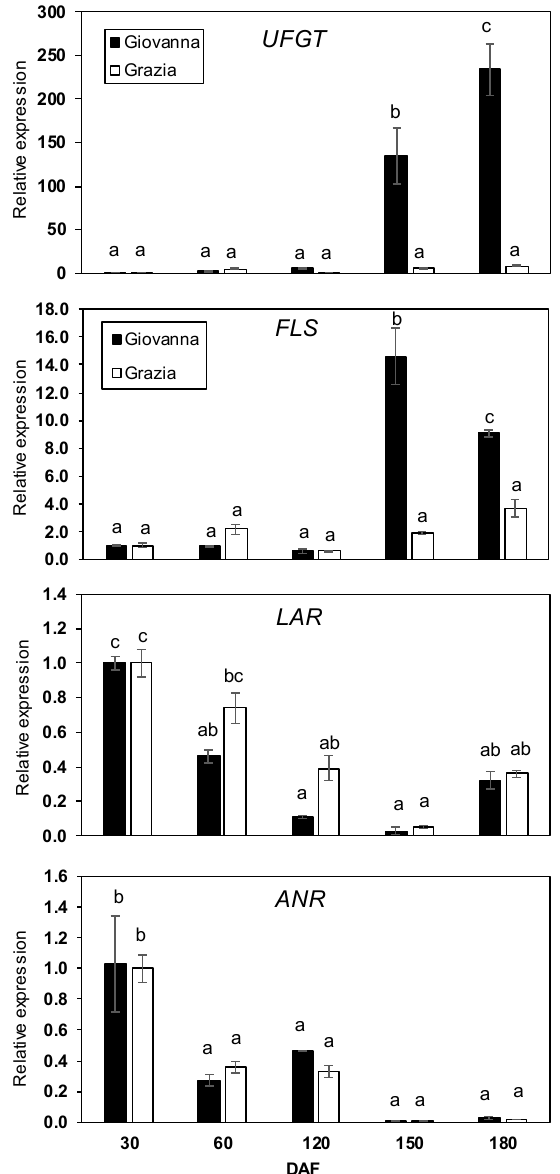
the formula 2 −ΔΔ Ct . Error bars represent standard error of three biological replicates. Every replica- tion consisted of 40 berries. Different letters represent statistically significant differences with Tukey’s B-test ( p < 0.05). Tukey’s B-test was carried out by comparing all means calculated at dif- ferent DAFs for both cultivars.